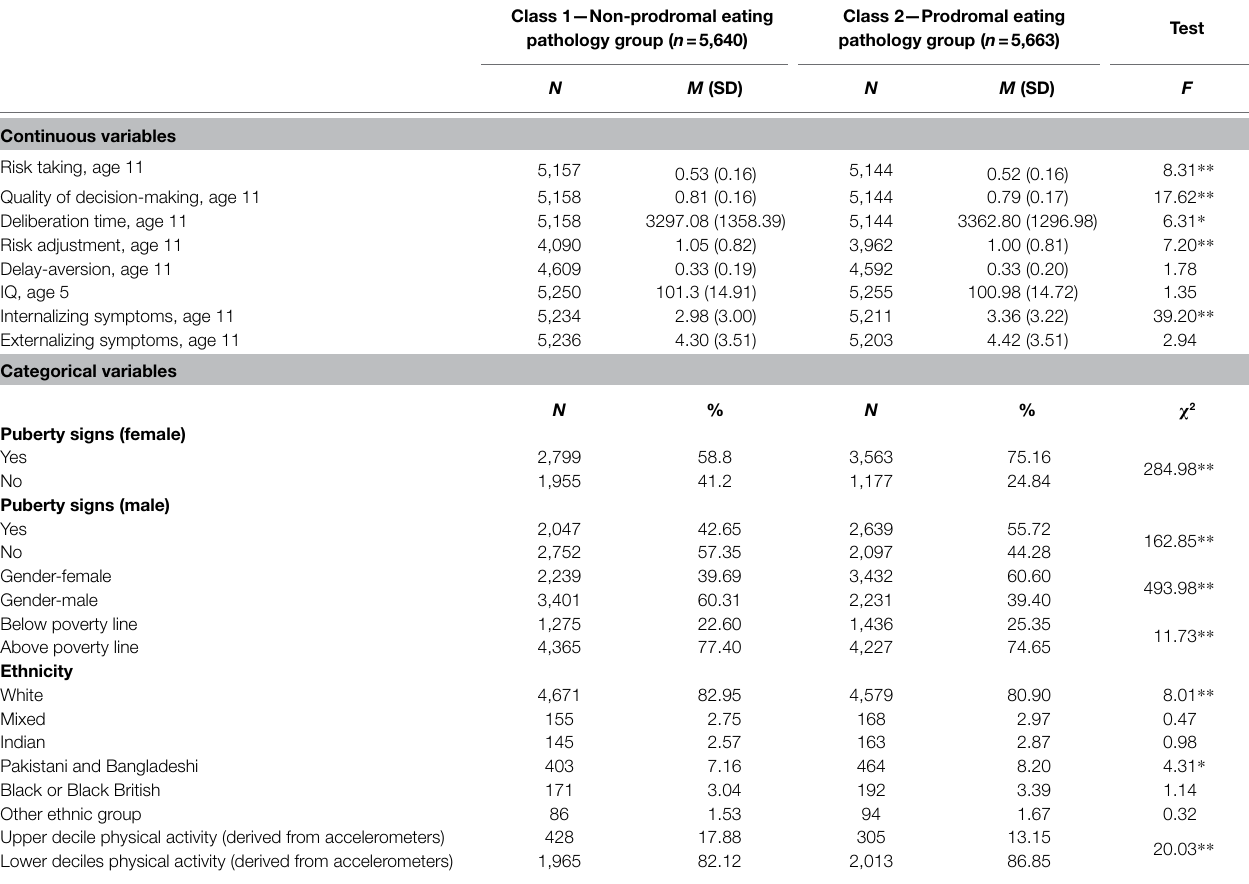
TABLE 4 | Distribution between classes of the study variables in the analytic sample ( n = 11,303;